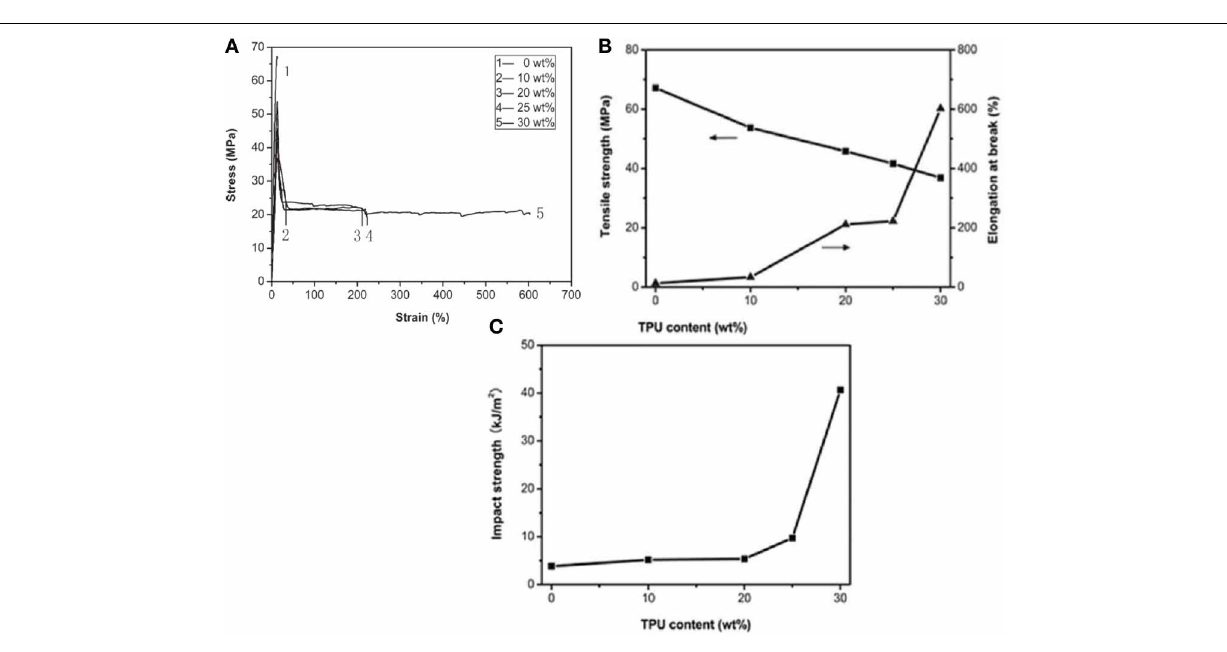
Ge et al. blended PLA with glycerol monostearate (GMS) (Ge et al., 2013) ( Figure 8 ). SEM micrographs of the impact frac- ture surfaces of PLA/GMS blends had a relatively good separation impact strength. The result showed that the addition of GMS